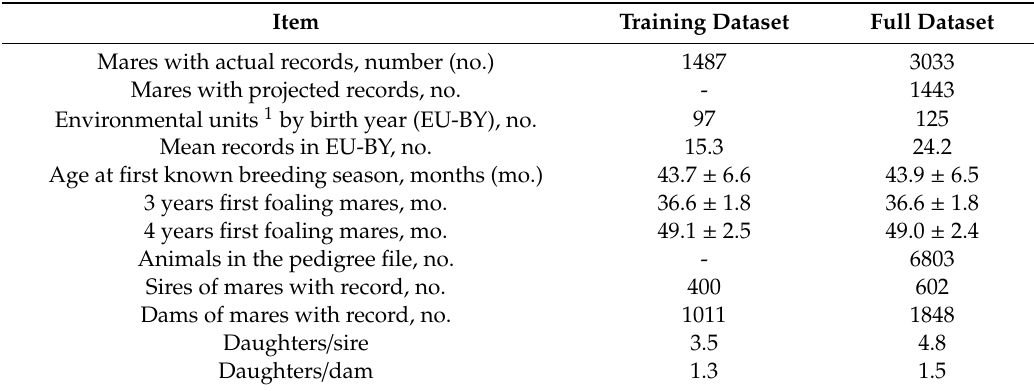
Table 1. Characteristics of the training and the full dataset used in the study. Item Training Dataset Full Dataset Mares with actual records, number (no.) 1487 3033 Mares with projected records, no. - 1443 Environmental units 1 by birth year (EU-BY), no. 97 125 Mean records in EU-BY, no. 15.3 24.2 Age at first known breeding season, months (mo.) 43.7 ± 6.6 43.9 ± 6.5 3 years first foaling mares, mo. Animals in the pedigree file, no. - 6803 Sires of mares with record, no. 400 602 Dams of mares with record, no. 1011 Daughters / sire Daughters /